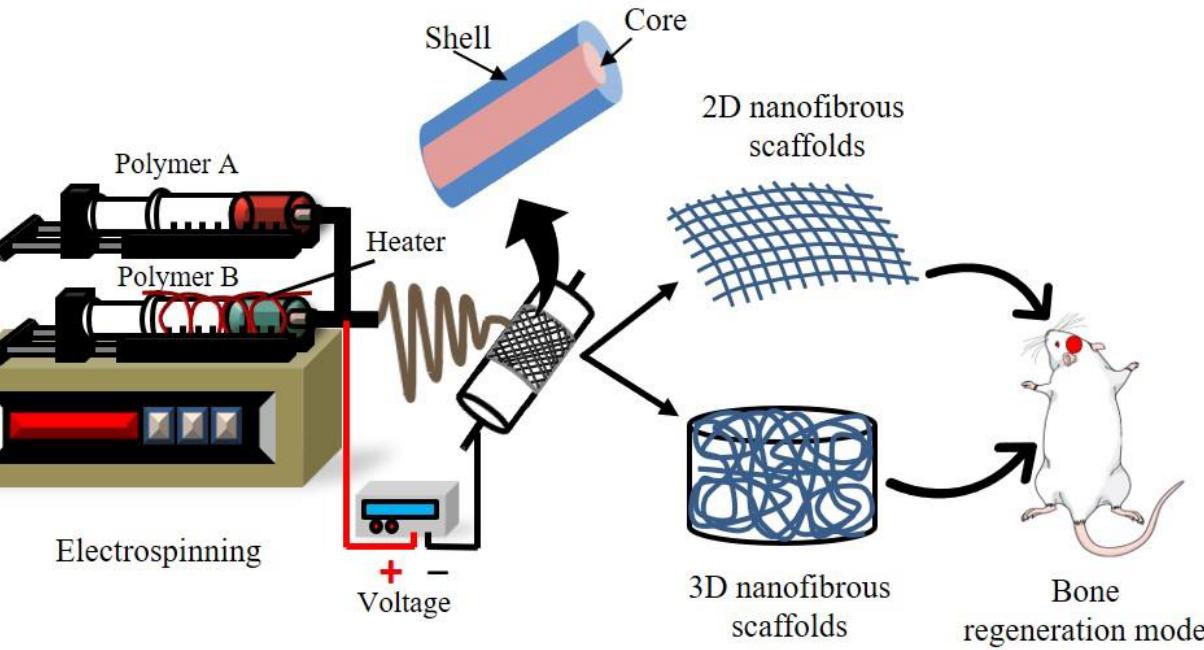
Figure 7. Diagrammatic representation of the production of 2D/3D nanofibrous scaffolds for bone regeneration using the melt electrospinning process.